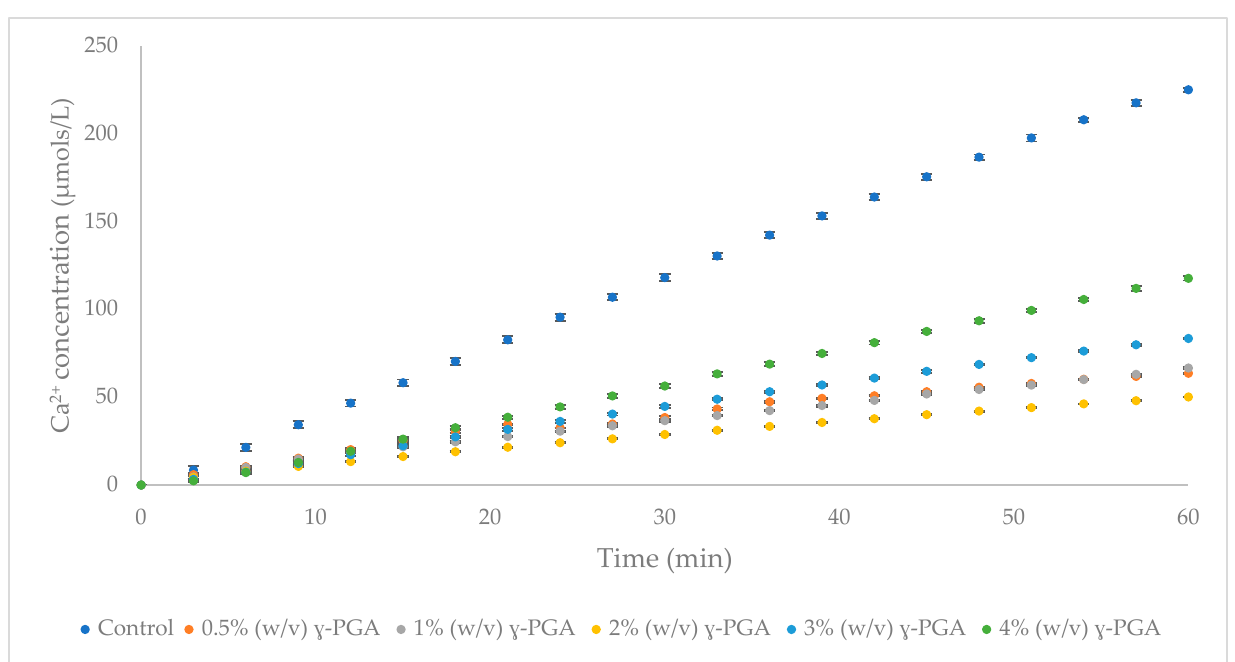
Figure 4. ISE study on the Ca 2+ dissolution from HAp discs (20% porous) after being treated for 2 min with analogous γ -PGA solutions at different concentrations. n = 3. Error bars indicate standard error values.